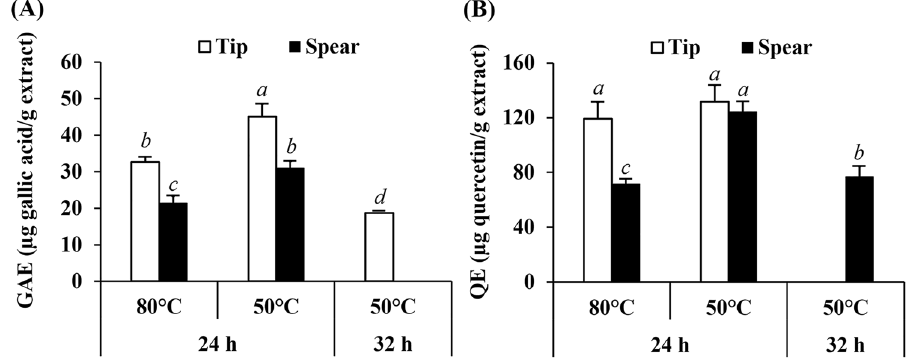
Figure 1. Total phenolic content in terms of gallic acid equivalent (GAE) of A. officinalis extracts prepared at different drying temperatures and drying duration ( A ). Total flavonoid content in terms of quercetin equivalent (QE) of A. officinalis extracts prepared at different drying temperatures and drying duration ( B ). Different letters, a, b, c, and d, denote significant differences in phenolic or flavonoid content among various A. officinalis extracts, whereas similar letters denote non-significant differences at p <